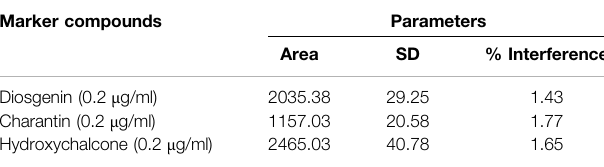
TABLE 5 | Selectivity study of diosgenin, charantin, and hydroxychalcone spiked at 0.2 μ g/ml in rat plasma. Marker